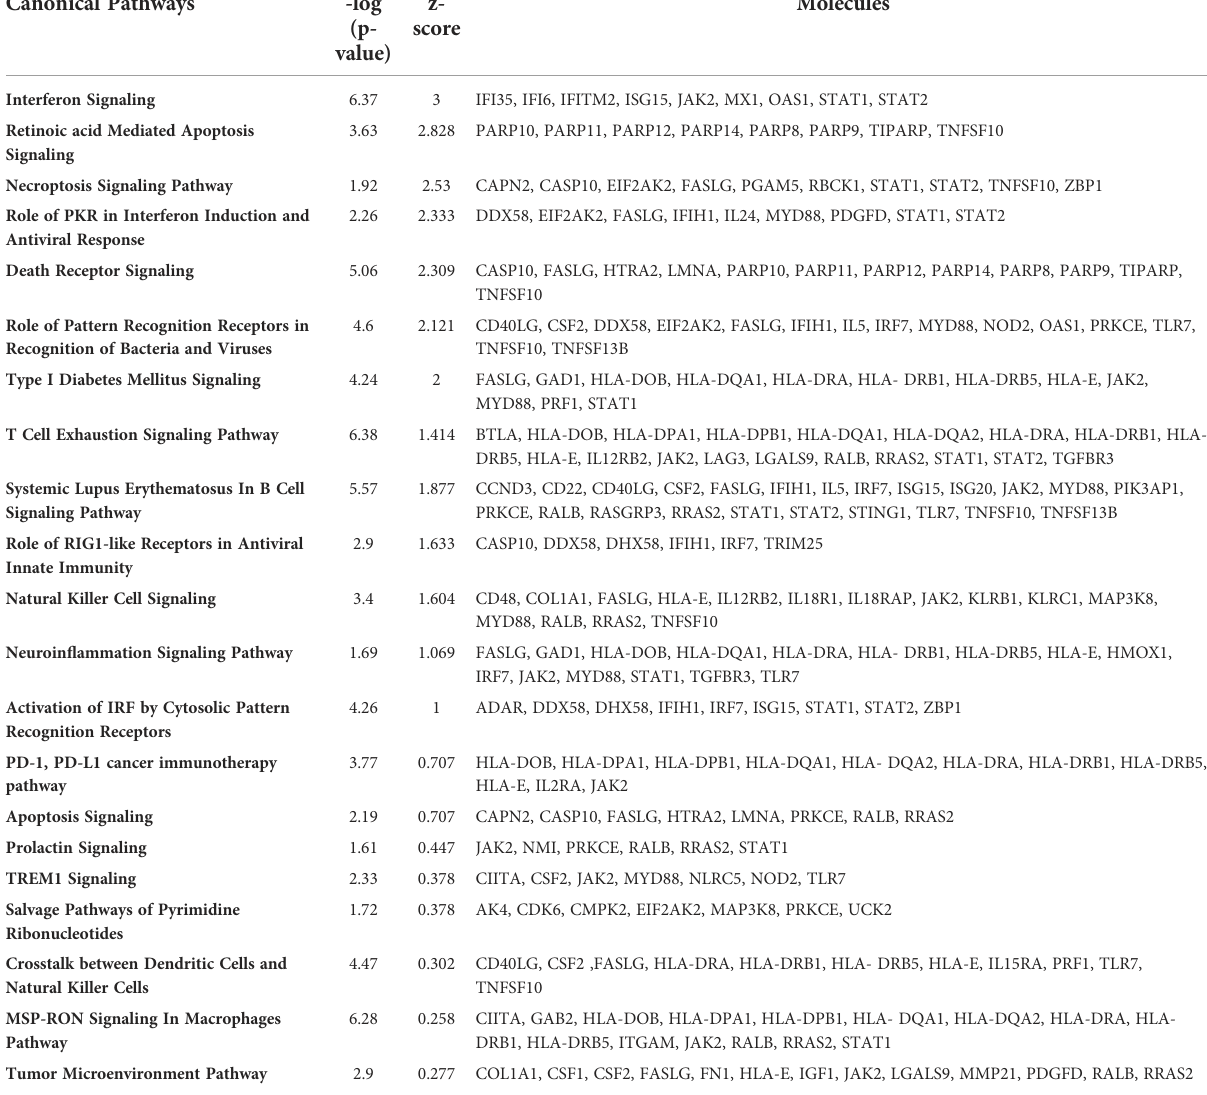
TABLE 1 Canonical pathways with positive Z-score. Canonical